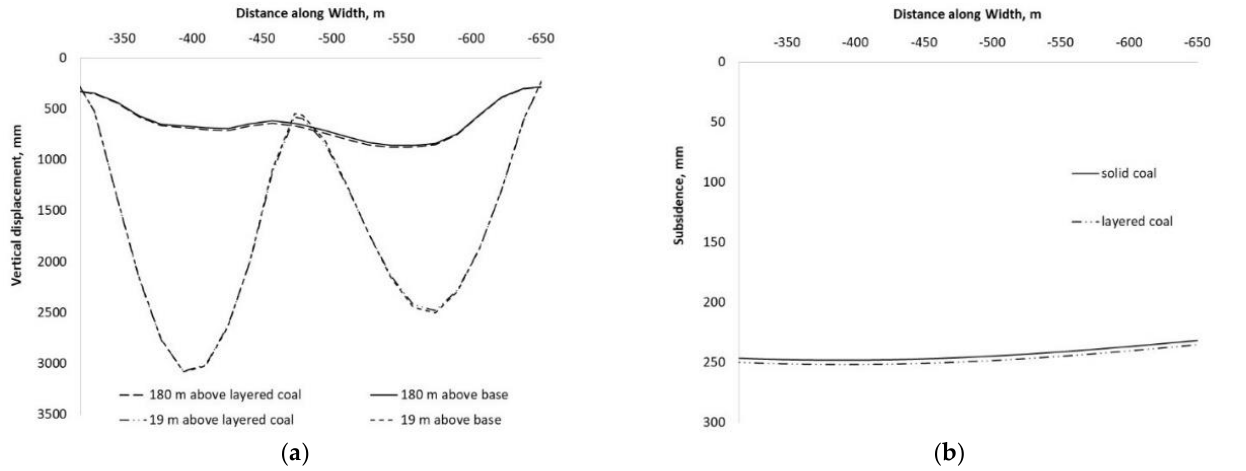
Figure 6. Comparison of strata deformation above longwalls 203 and 204. ( a ) Vertical displacement at 19 m above the mining seam; ( b ) ground subsidence.